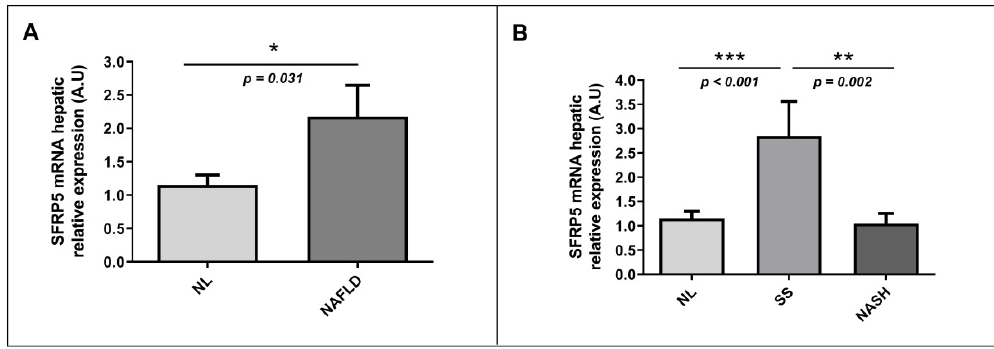
Figure 3. Differential relative mRNA abundance of SFRP5 in liver between ( A ) women with MO with NL histology and women with MO with NAFLD and ( B ) MO women with NL, SS, and NASH. A.U, arbitrary units; MO, morbid obesity; NAFLD, nonalcoholic fatty liver disease; NL, normal liver; SS, simple steatosis; NASH, nonalcoholic steatohepatitis; SFRP5; secreted frizzled-related protein 5. p < 0.05 was considered statistically significant (* means p < 0.05; ** means p < 0.01; *** means p < 0.001).